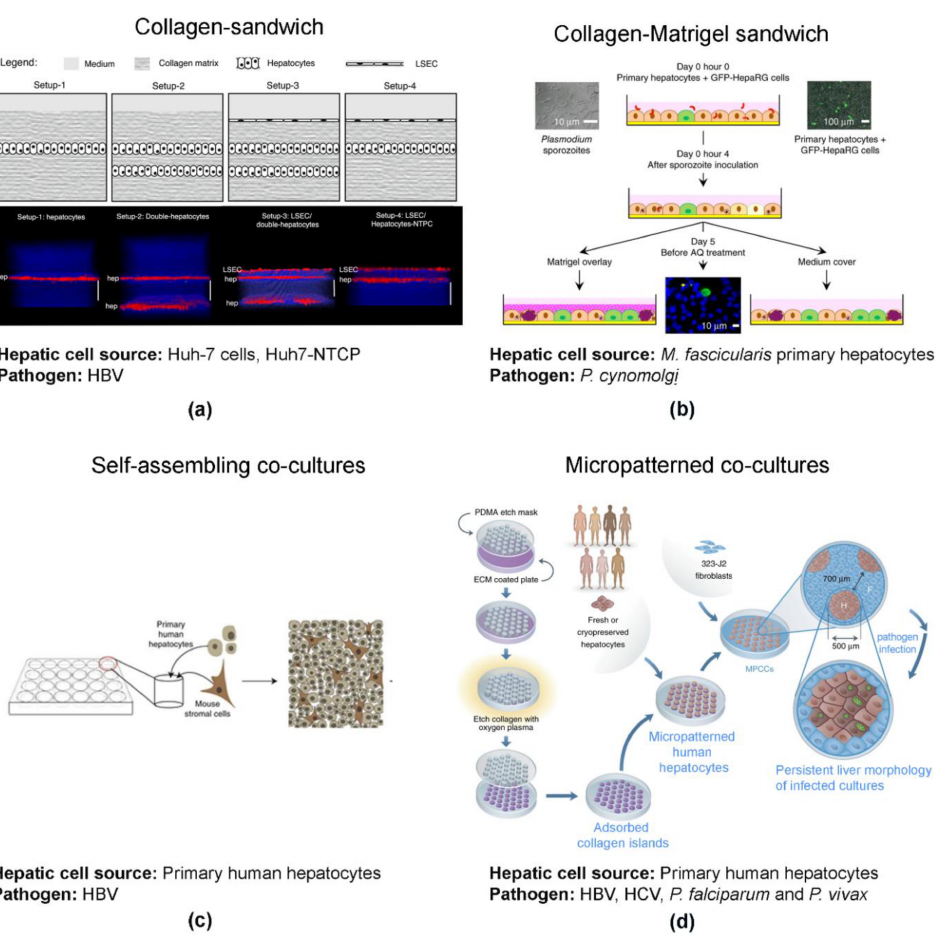
Figure 1. Engineered 2D models for addressing infection by hepatotropic pathogens. ( a ) Collagen-sandwich of a monolayer (setup-1) or double-layer (setup-2) of human hepatic cells without or with (setup 3 and 4, respectively) the presence of